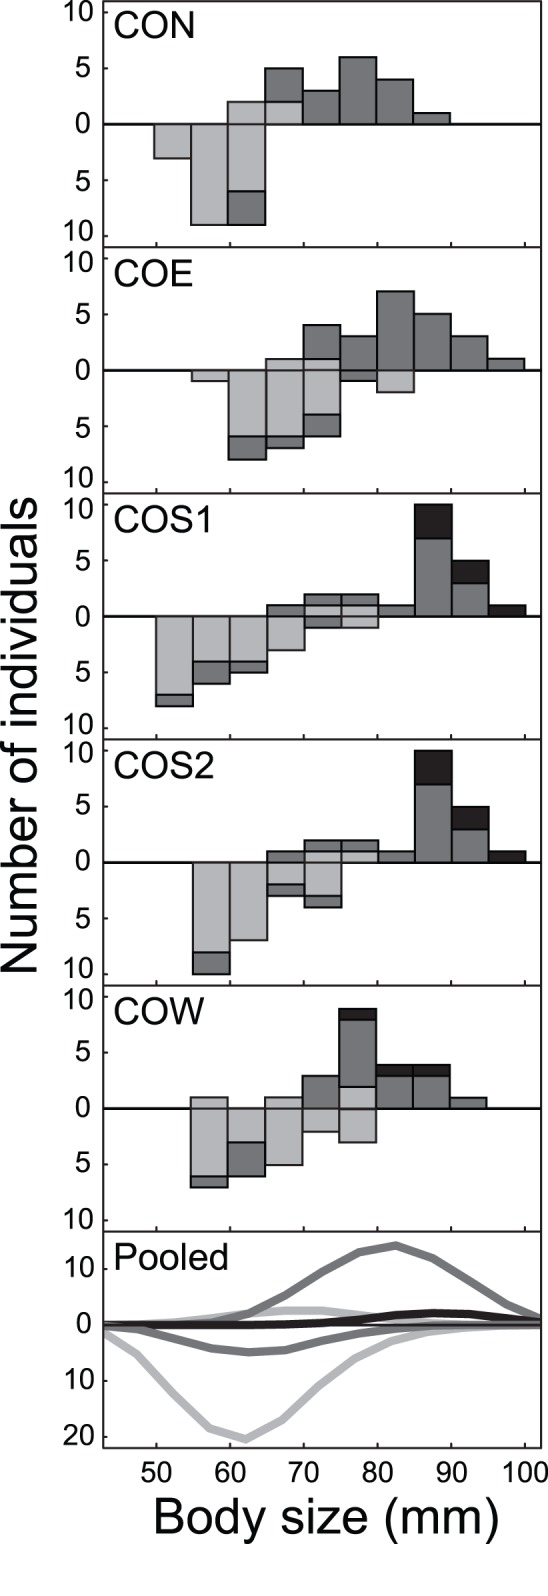
Age and body size at reproduction in lake and stream stickleback from the Lake Constance basin.The top panels show body size (quantified as landmark-based centroid size) histograms for each lake-stream system separately, with the lake data pointing upward and the stream data pointing downward. Proportions are shaded according to age class; individuals in their second, third, and fourth calendar year are drawn in light gray, dark gray, and black. The bottom panel follows the same drawing conventions, except that here the data are pooled across all systems within each habitat type, and smoothed by LOESS (locally weighted scatterplot smoothing) for each age class separately. Note the striking shift toward greater age and size at reproduction in lake stickleback as compared to their conspecifics from streams.